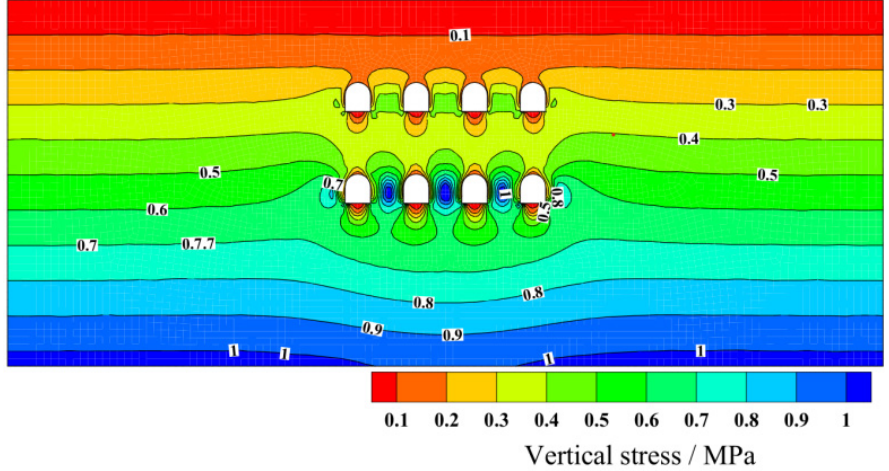
Figure 4. Vertical stress field distribution.